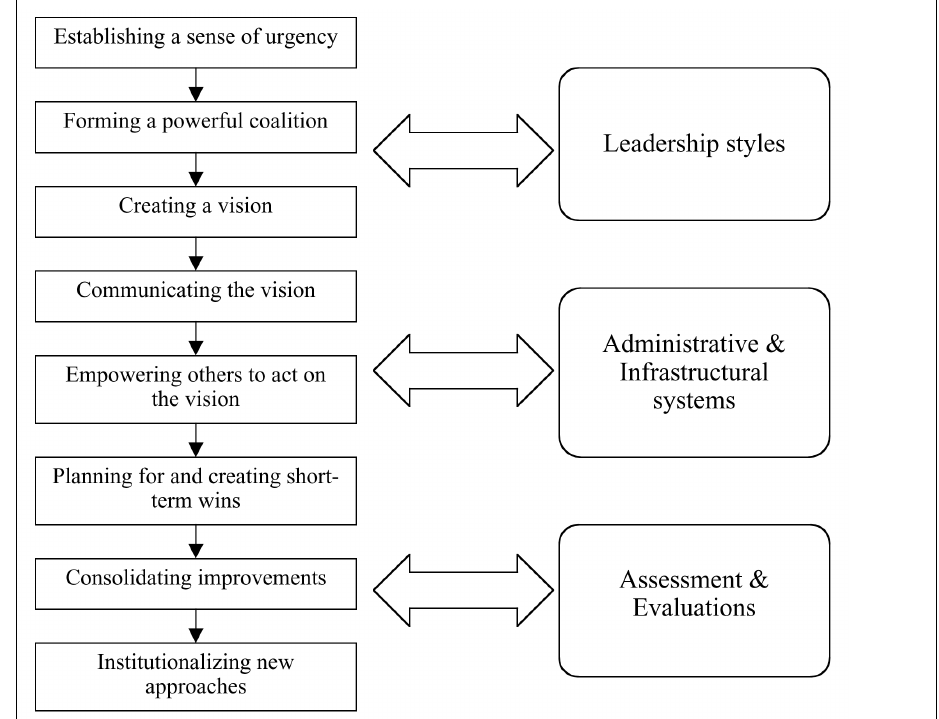
Figure 1: Conceptual